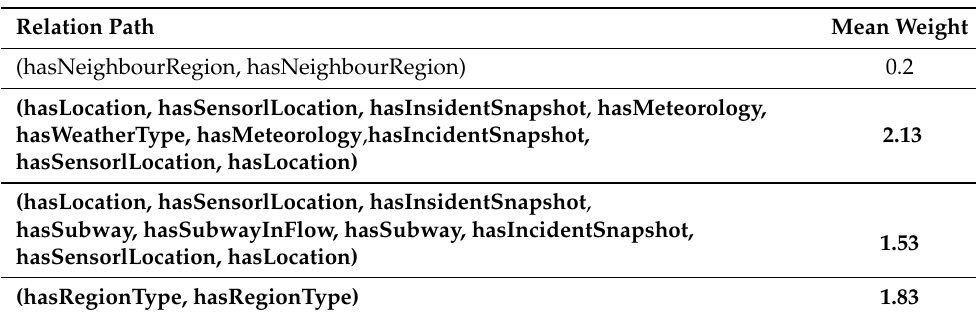
Figure 6. Part of the urban knowledge graph for traffic accident inference tasks. Table 4. Explanations of the resultsbased on global graph features for traffic accident